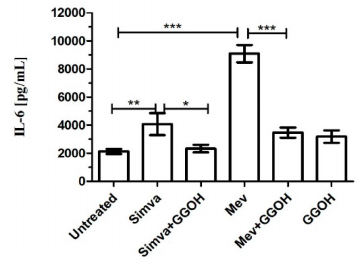
Figure 7. Deregulated IL-6 production after treatments on Daoy cells: treatments with Simvastatin (10 µ M) and Mevalonate (10 mM) in the presence or absence of GGOH (50 µ M) for 24 h. Geranylgeraniol was dispensed 24 h after the Simvastatin or Mevalonate treatments. The concentration values of IL-6 (pg/mL) were obtained from experiments performed in triplicate. IL-6 was significantly modulated with isoprenoids treatments. One way ANOVA test followed by the Bonferroni correction for multiple comparisons * p < 0.05, ** p < 0.01, *** p <